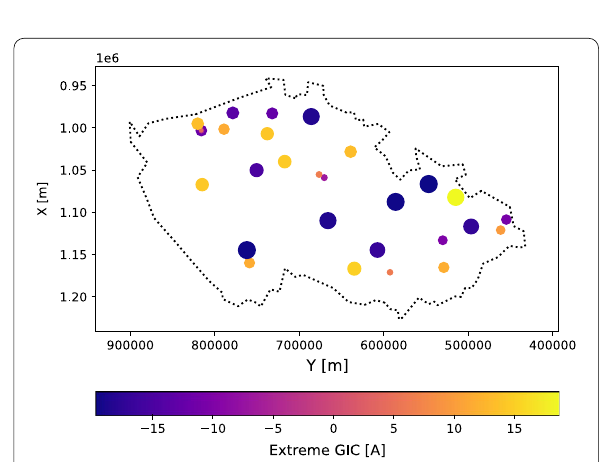
Fig. 6 Extreme values of GICs in the investigated substations during the whole period of Halloween storms